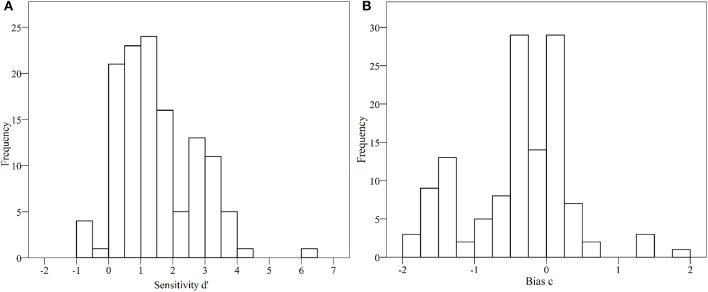
(A,B) Histogram of sensitivity d' (left) and response bias c (right) for the sample of music students (y-axis indicates frequencies).